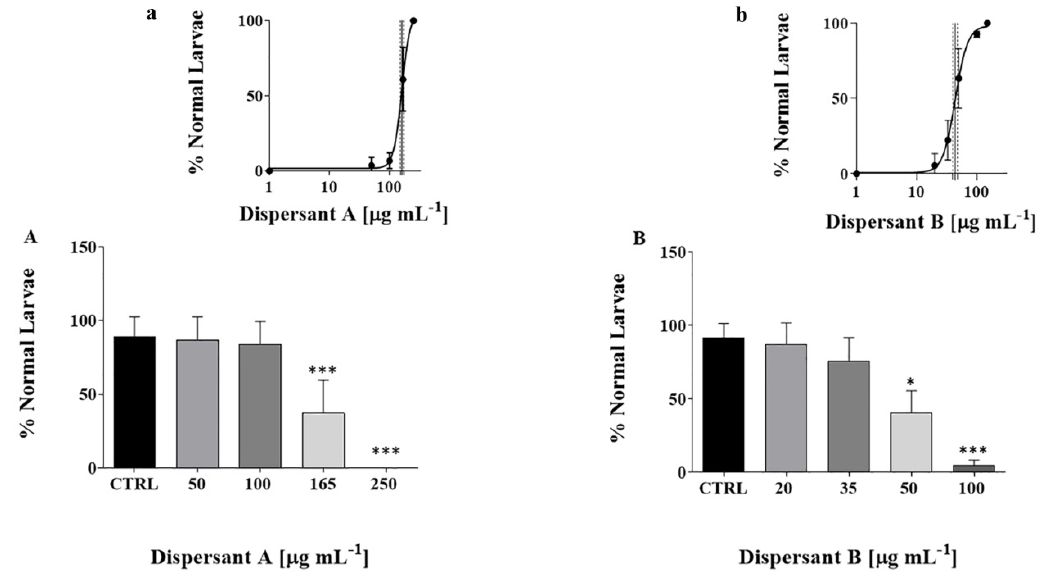
Figure 1. Percentage (%) of normal hatched larvae of C. robusta upon exposure to dispersant A ( A ) and dispersant B ( B ) in NSW for 22 h. Bars represent mean ± SD (dispersant A n = 2700; dispersant B n = 2700). Asterisks indicate values that are significantly different compared to the control (Kruskal-Wallis test, Dunn’s post hoc test, * p < 0.05, *** p < 0.001). In the upper part of the graphs ( a , b ), curves represent the nonlinear regression of normal larval development data (sigmoidal) with the best fit for EC 50 values (dashed lines) as well as the relative 95% CIs (dotted lines). Error bars represent standard deviation.